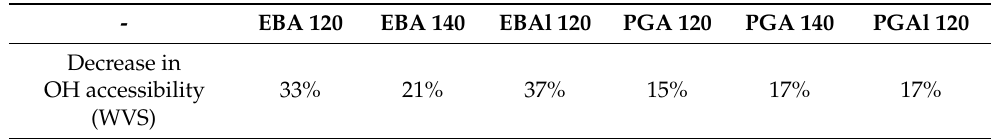
Table 6. Percentage decrease in accessible OH between treated and untreated wood samples for the methods WVS (water vapor sorption).